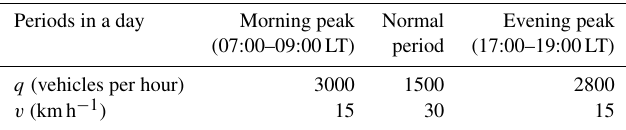
Table 2. Number of vehicles passing a given cross section of the road per hour ( q ) and the average speed of vehicles on Kennedy Road ( v ) for different periods in a